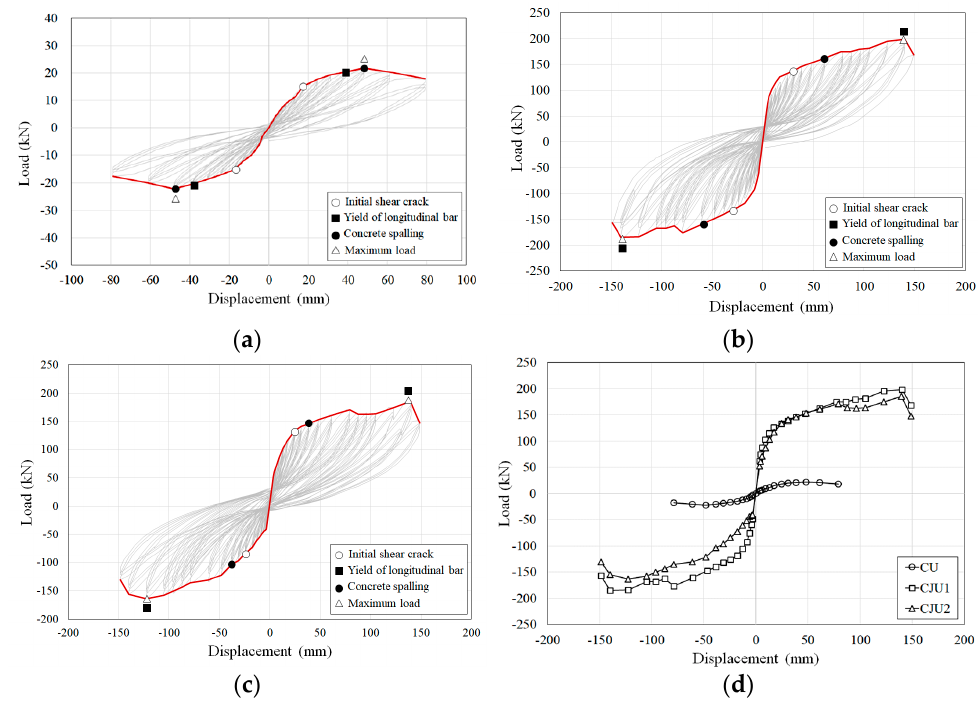
Figure 7. Hysteresis envelope curves: ( a ) CU; ( b ) CJU1; ( c ) CJU2; ( d ) Skeleton curves of all specimens.